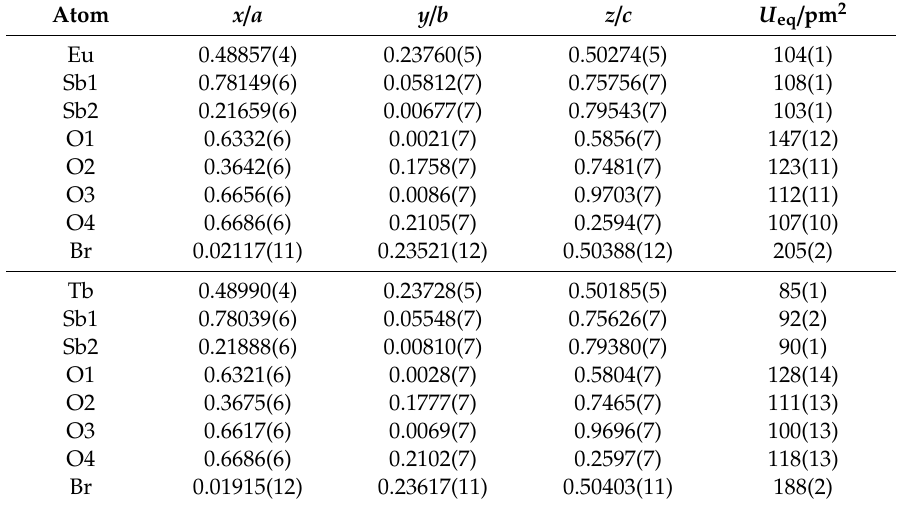
Table A2. Fractional atomic coordinates and coe ffi cients of the equivalent isotropic displacement